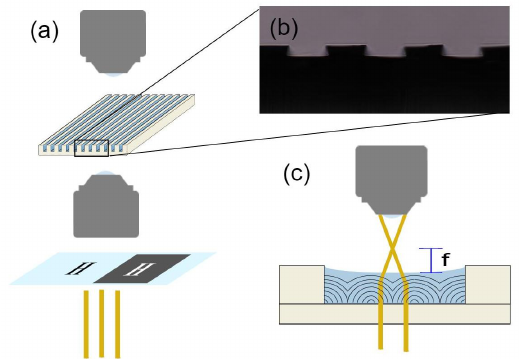
Figure 5. Experimental setup. ( a ) Schematic of the setup used to test lensing ability of LC defects in the microchannel array. A mask made out of marker (hand-drawn letter H) on a glass slide, or a paper cutout of the letter, is placed in front of the light source behind the condenser, then the sample and the formed image are viewed through an upright microscope. ( b ) Cross-section of a poly-di-methyl-siloxane (PDMS) mold showing the profile of the micro-fabricated channels, viewed under an optical microscope. ( c ) Schematic depicting image formation of the mask by a lens. The sample is adjusted vertically until the image is in focus at a distance f above the